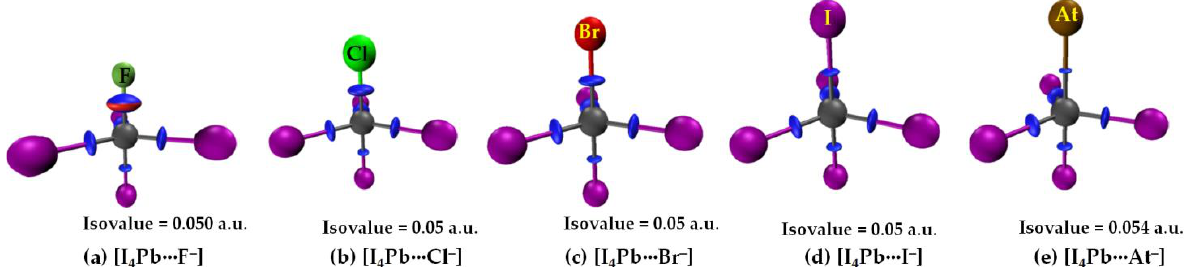
Figure 11. ( a – e ) [ωB97X -D/def2-QZVPPD] level IGM- δg inter -based isosurface plots (bluish-red volumes) of [I 4 Pb···X − ] (X = F, Cl, Br, I, At), showing possible Pb···X tetrel bonded interactions between interacting molecular entities.